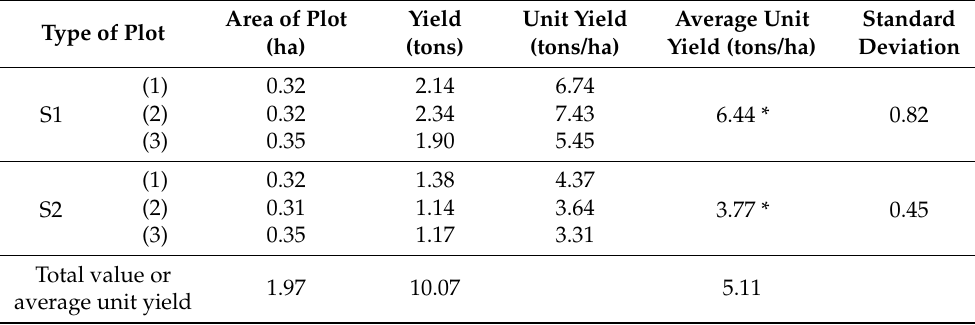
Table 1. Yield and unit yield of each